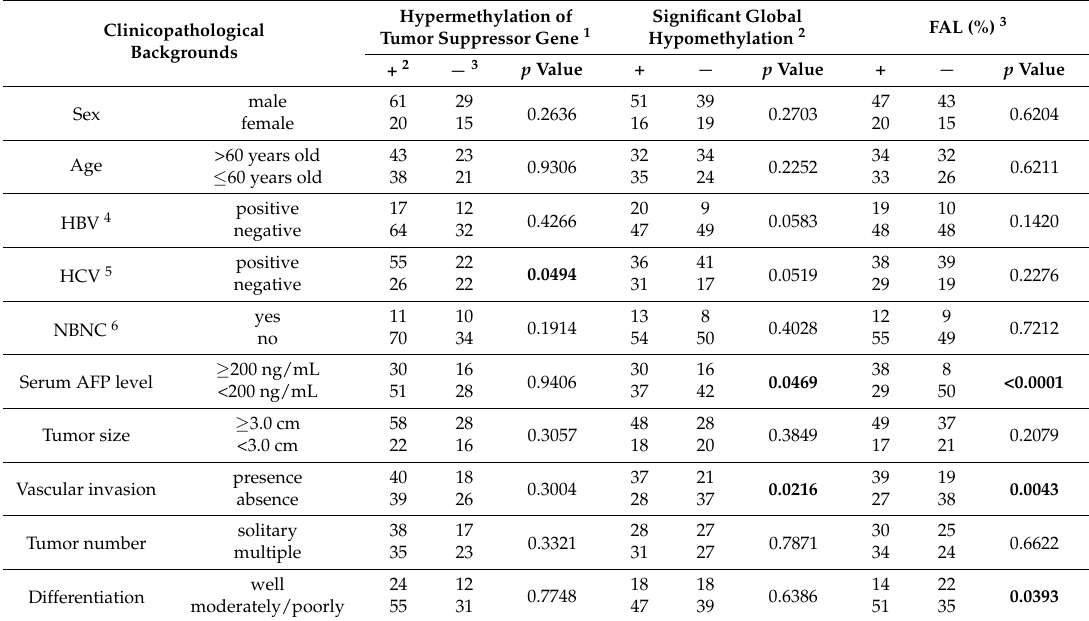
Table 2. Methylation status and chromosomal alterations of HCC and clinicopathological backgrounds in the cohort of liver